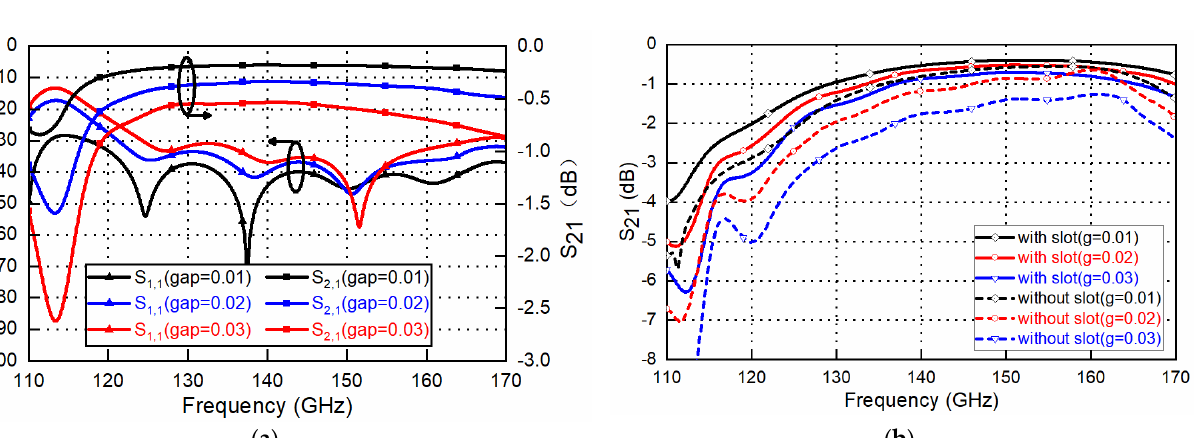
Figure 4. Simulation model of the air-filled GWG, based on the glide-symmetric holey EBG. After stacking the top and bottom layers, a rectangular GWG line with the dimen-